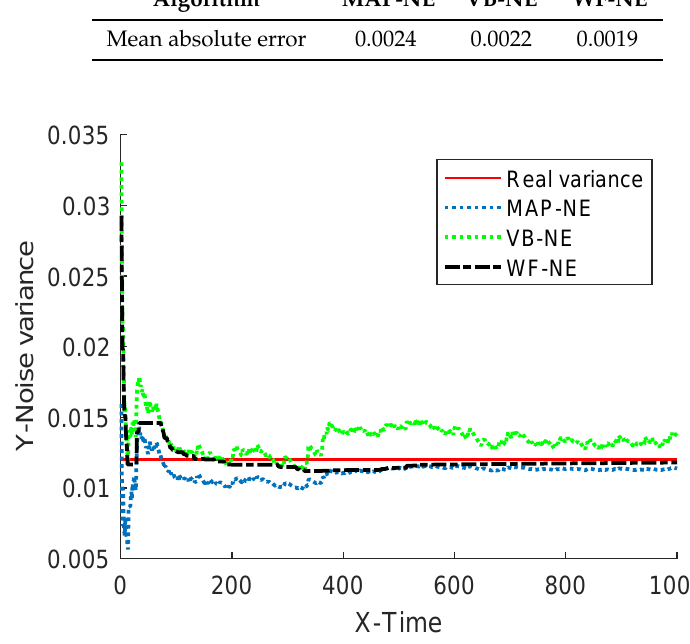
Figure 2. Estimation of measurement noise